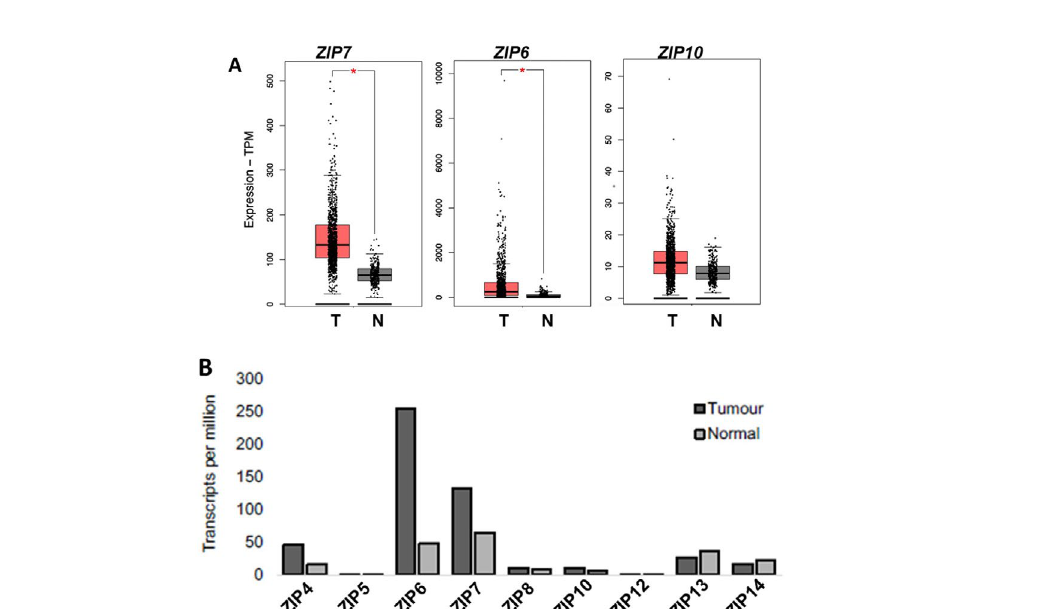
Figure 3. Differential expression profiles of ZIP family members in paired cancerous versus normal breast tissue, including focused analysis of ZIP4, ZIP7, ZIP6, and ZIP10. (A) Expanded analysis of LIV-1 subfamily members of ZIP-family transporters in matched normal versus tumour patient samples. (B) Focussed analysis of matched tumour and normal breast tissue levels of ZIP4, ZIP7, ZIP6, and ZIP10. Red and grey boxes represent cancerous (T) and matched normal (N) tissue, respectively. All plots were produced by GEPIA 2 server [19] and describe matched gene expression data derived from TCGA and GTEx databases. Data was filtered to show only differential gene expression relationships with a P- value threshold of 0.01. Log2FC cut-off was designated as 1. Patient numbers ( n ) in cancerous (T) and normal (N) cohorts were 1,085 and 291 respectively. TPM: transcripts per